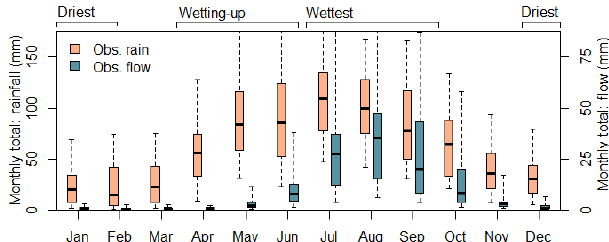
Figure 6. Seasonal variation of catchment average rainfall and flow at Houlgrave Weir. Boxplots show the variation across years. “Wettest” indicates months with higher rainfall and higher flow. “Driest” indicates months with lower rainfall and lower flow. “Wet- ting up” indicates months with higher rainfall and lower